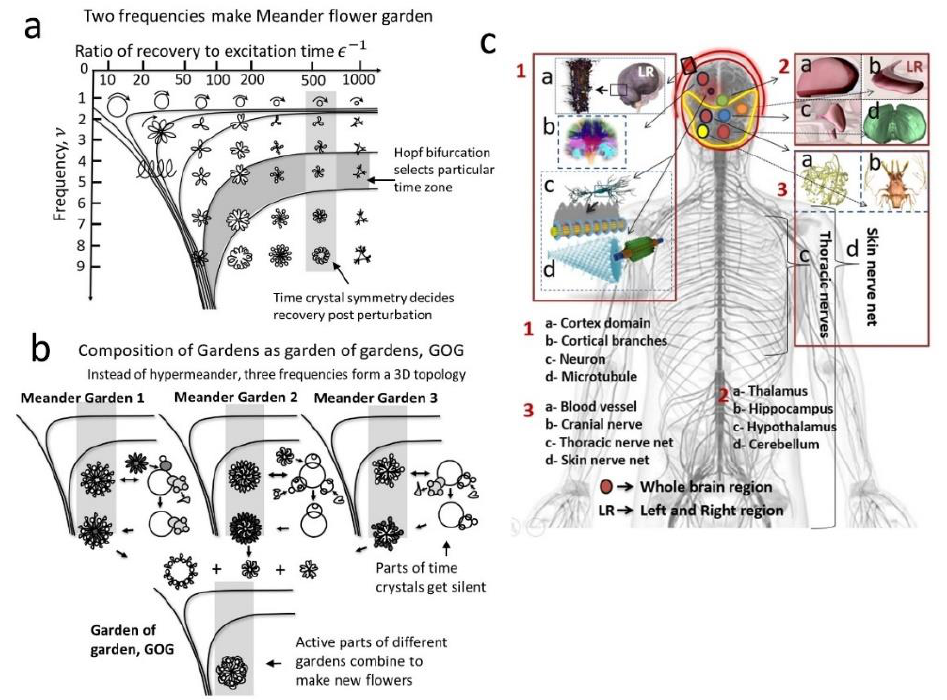
Figure 2. ( a ) The recovery time of a clock when perturbed is calculated and represented by a pair of circles, one touching the other internally, externally or on top of it. One circle or host clock represents the original clock and the other clock represents perturbation. The system point is placed on the guest clock and combined or effective motion of the system point is plotted. When guest clock becomes smaller, relative to host frequency increases, and recovery to excitation time is plotted. The relative motion could change as a function of input perturbation time and frequency of the signal used. Consequently, the pair of nested clocks change relative diameter, phase positions, which generates a